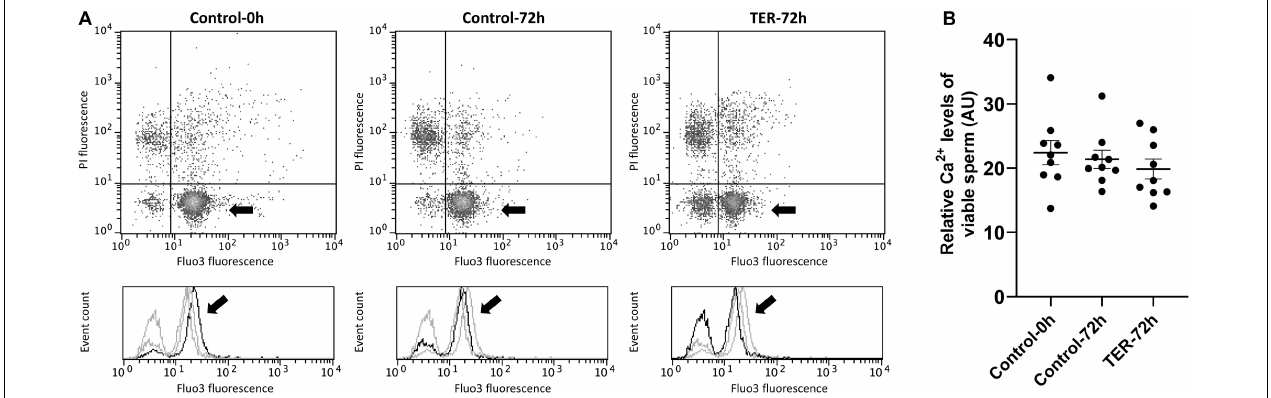
FIGURE 9 | Flow cytometry analysis of intracellular calcium levels. (A) Representative flow cytometry dot plots of propidium iodide (PI) and Fluo3-AM (Fluo3) fluorescence and histograms showing the event count of Fluo3 fluorescence intensity of all treatments. Black arrows show the flow cytometry population selected for analysis represented in (B) . Dark gray lines in histograms show the event count of its corresponding treatment, whereas light gray lines show the event count of the remaining treatments. (B) Mean, standard error of the mean (SEM), and sample distribution of the relative Fluo3 + fluorescence intensity of the viable sperm population in all treatments. Control-0h, semen samples at 0 h of storage; Control-72h, vehicle control (dimethyl sulfoxide; DMSO) samples at 72 h of storage at 17 ◦ C; TER-72h, semen samples treated with 100 µ M ezatiostat (TER) for 72 h of storage at 17 ◦ C. Sample size ( n = 9). p > 0.05.